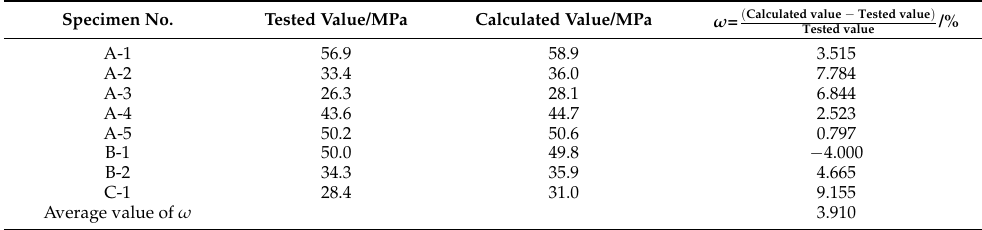
Table 4. Tested and calculated values of peak stress.